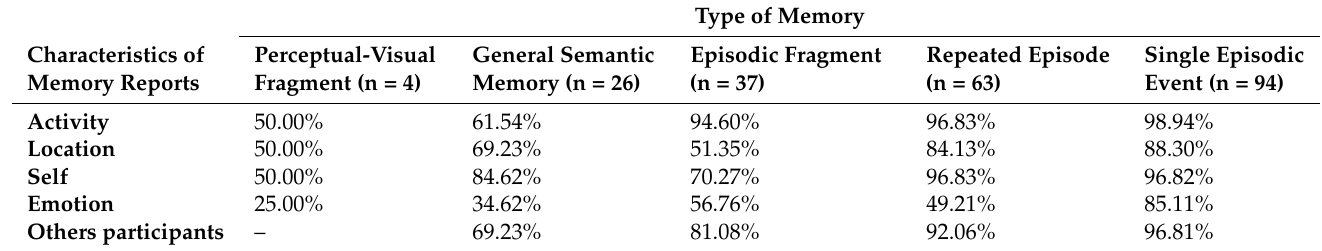
Table 6. Frequencies of the details reported according to the different types of memories when present in epoch 2 (the different types of memory reported are